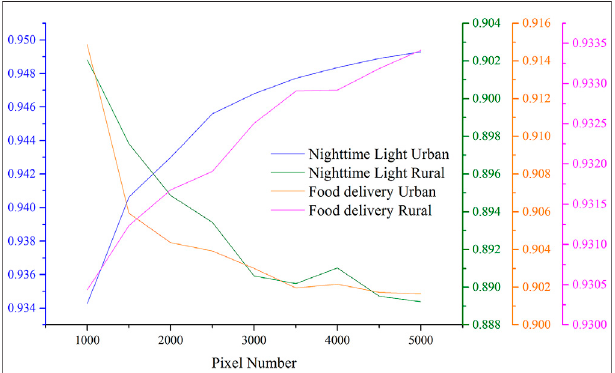
FIGURE 7 | Percentage of different random assessment points in the urbanandruralareas(Theaccuracyofresultsveri fi edby1,000 – 5,000random veri fi cation points is shown in the fi gure, in which the accuracy of NTL data identi fi cation in urban areas and food delivery identi fi cation in rural areas shows an increasing trend, while the accuracy of NTL data identi fi cation in rural areas and food delivery data identi fi cation in urban areas shows a decreasing